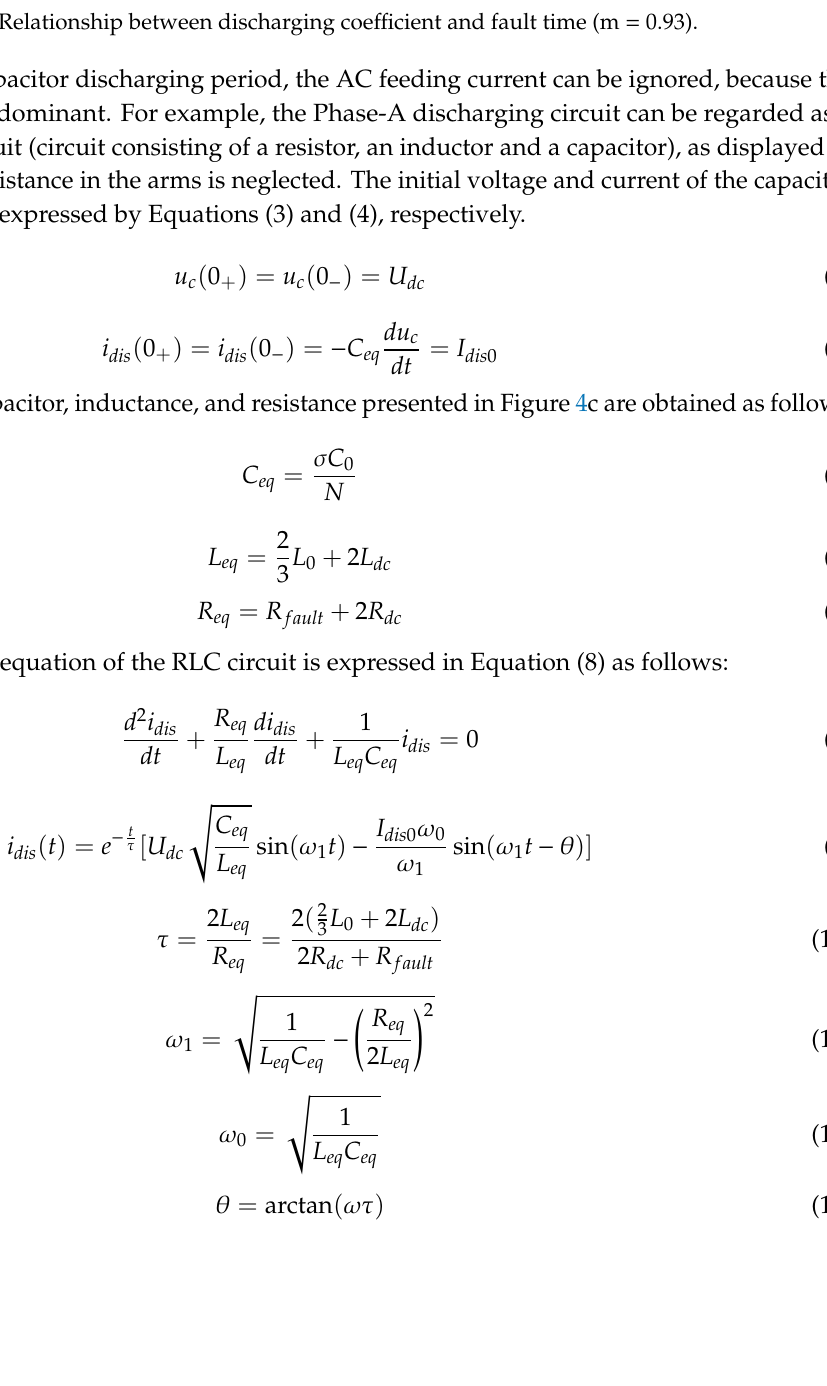
current circuit, ( c ) simplified SM capacitor discharging current circuit.